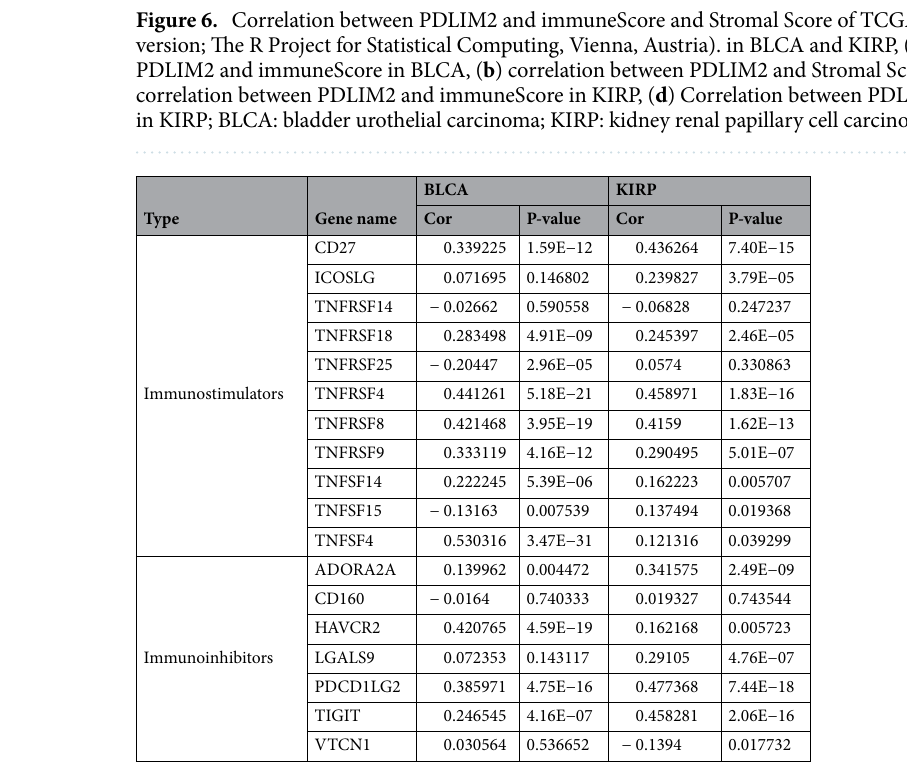
Table 2. Correlation analysis between PDLIM2 and immune checkpoint genes in BLCA and KIRP of TCGA dataset by R (3.6.3 version; The R Project for Statistical Computing, Vienna,